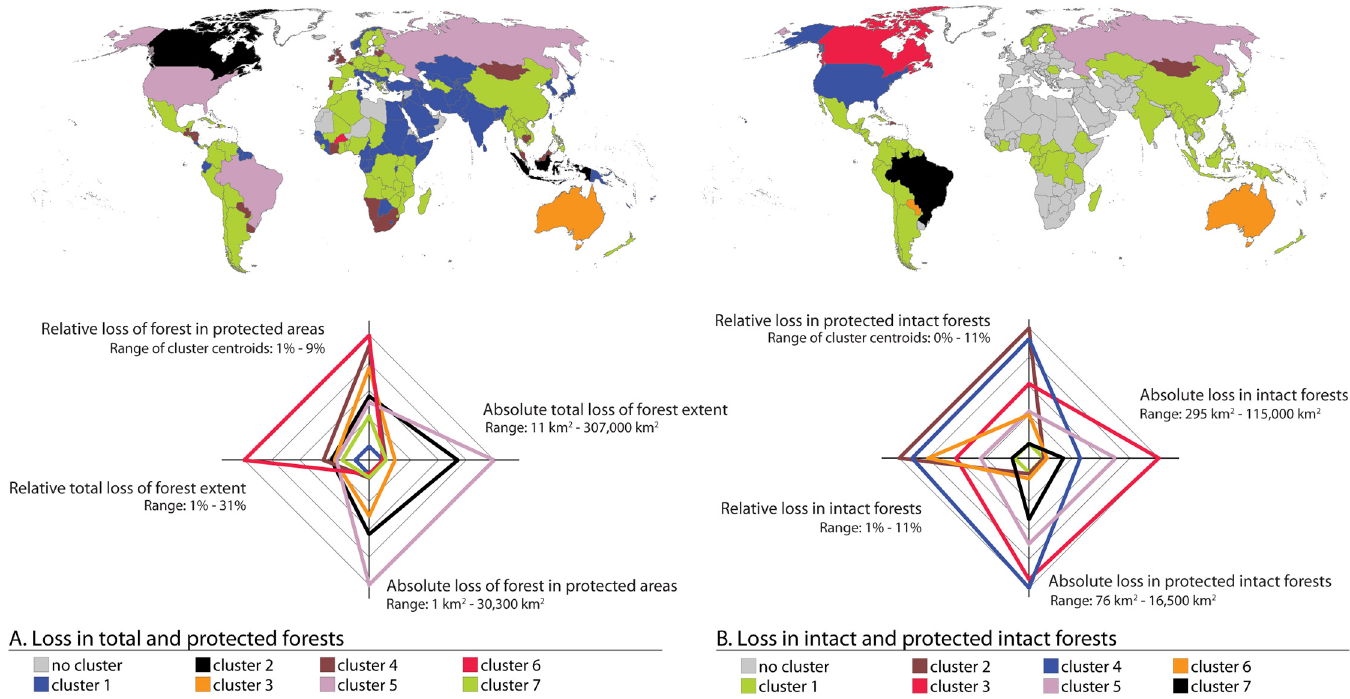
Fig 4. Clustering of countries by their forest loss patterns. A) country clusters based on absolute and relative losses in total and protected forest; and B) country clusters based on intact and protected intact forest. The cluster characteristics are illustrated by radar charts, of which radii represent the variables used in the clustering. The absolute range in each variable is given next to the variables. The cluster centroids on each variable are plotted on the radii, and these centroids are connected with lines. The countries within each cluster are mapped above the corresponding radar chart and the colours both, in the radar charts and their corresponding maps, indicate the cluster in question.